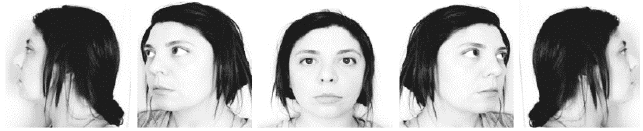
Figure 1. Due to copyright issues, exemplification of the position used from the Karolinska Directed Emotional Faces (KDEF) battery.